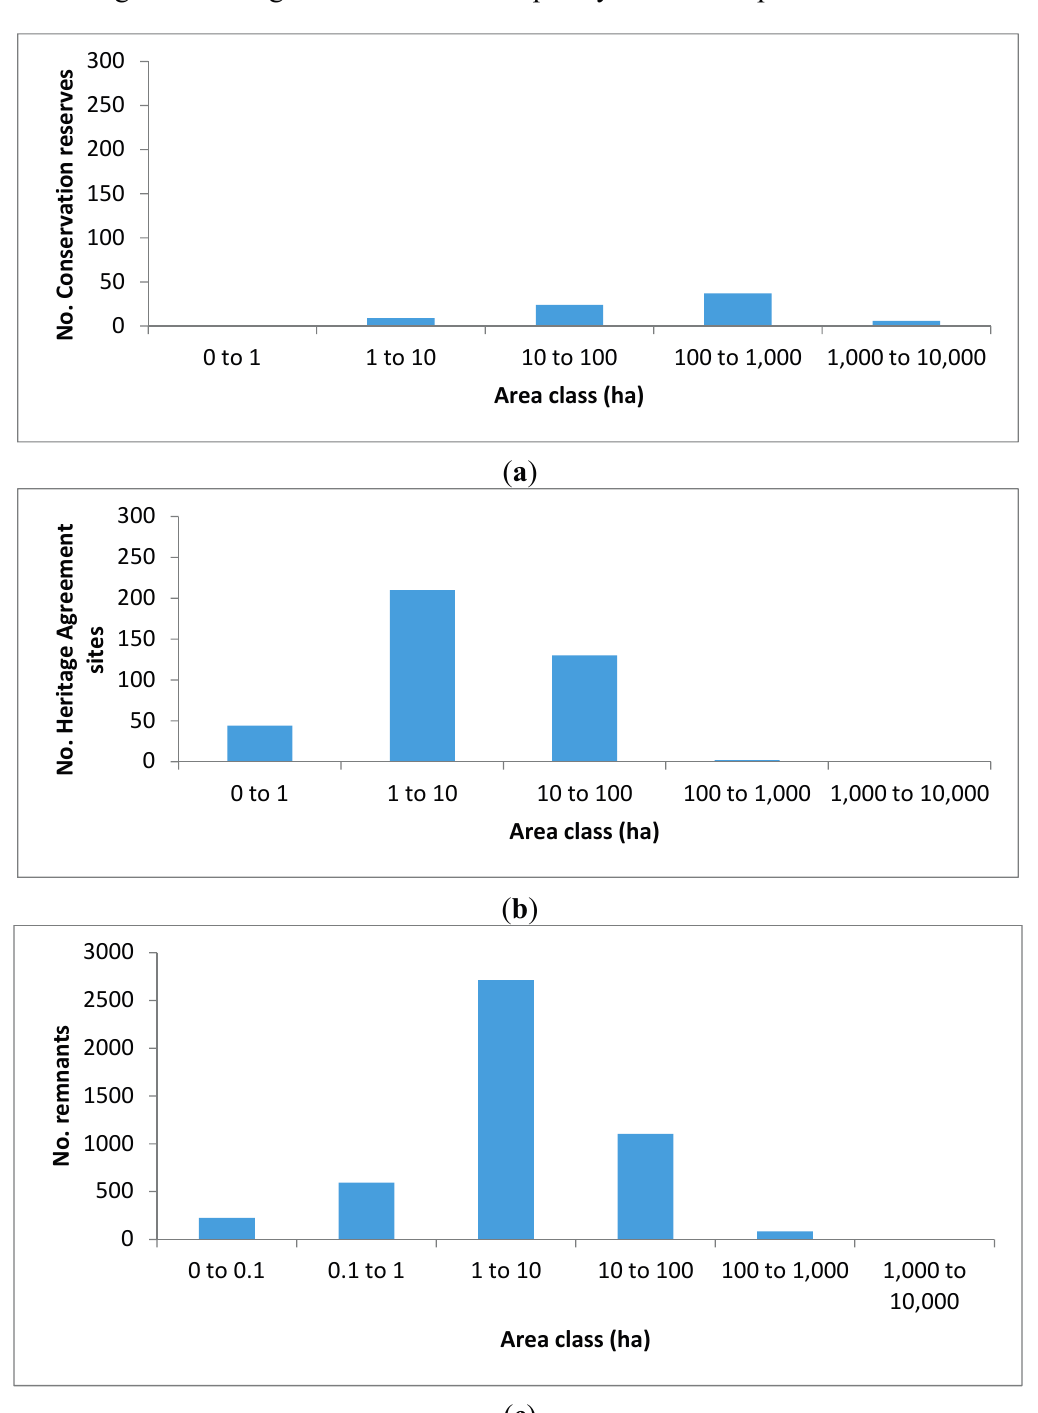
Figure 3. Frequency distributions of areas of: ( a ) official conservation reserves; ( b ) “Heritage Agreement” sites; and ( c ) remnant vegetation patches. Note the order-of-magnitude change of scale for the frequency of remnant